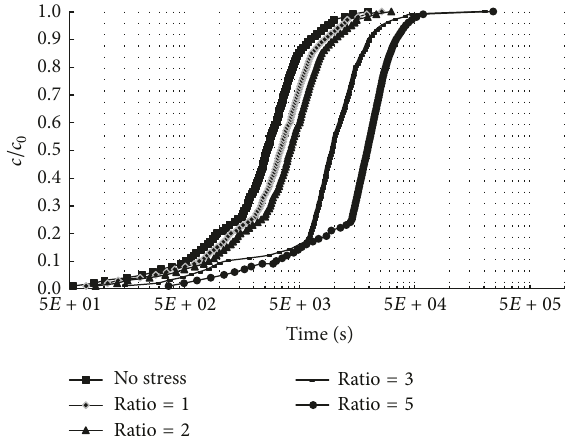
Figure 14: Breakthrough curve with different stress ratios without matrix